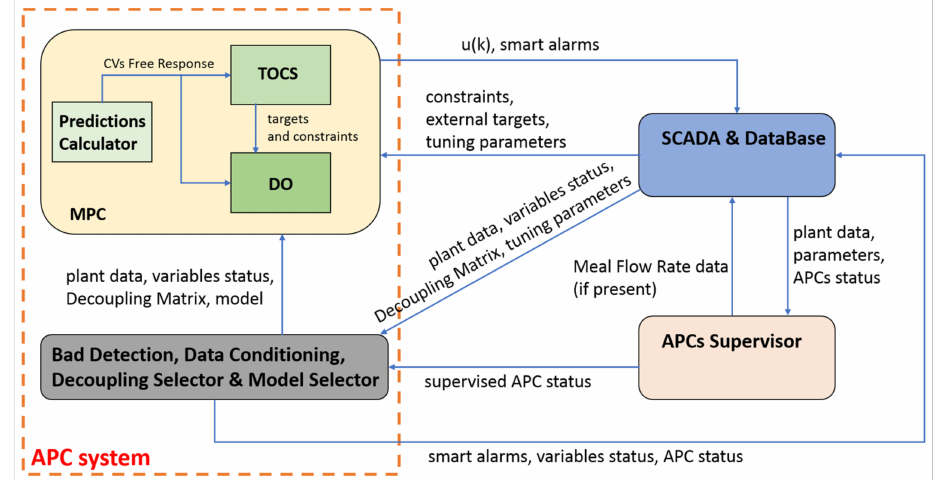
Figure 5. Details on the modules of the APC